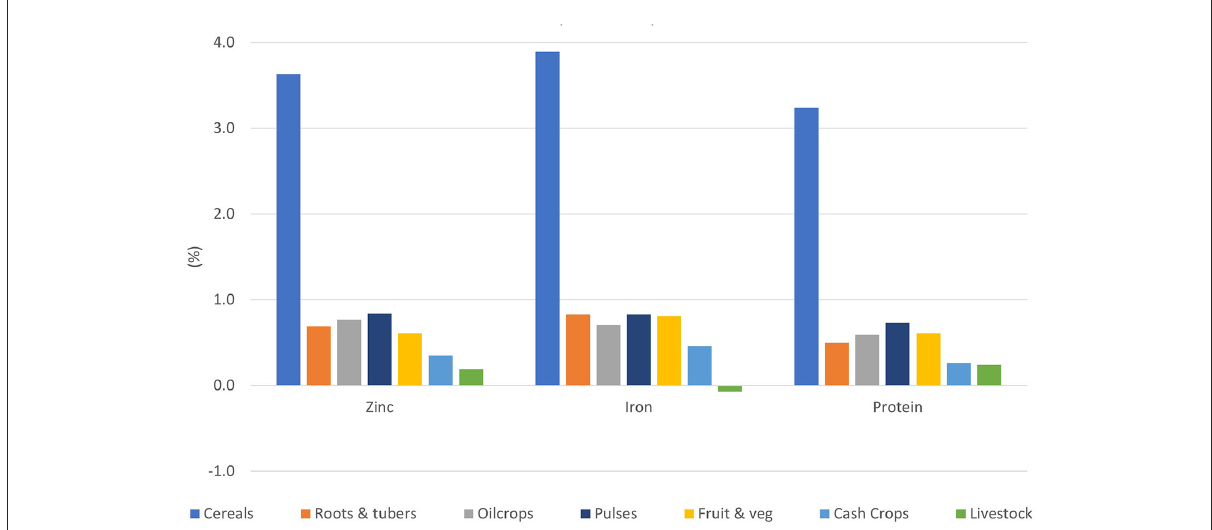
FIGURE3 Changes in RNI ratios for protein, iron and zinc from increases in commodity productivity. The figure shows the percentage change in RNI ratios for three nutrients resulting from productivity growth in the respective commodity groups. The figure draws from results reported in Table